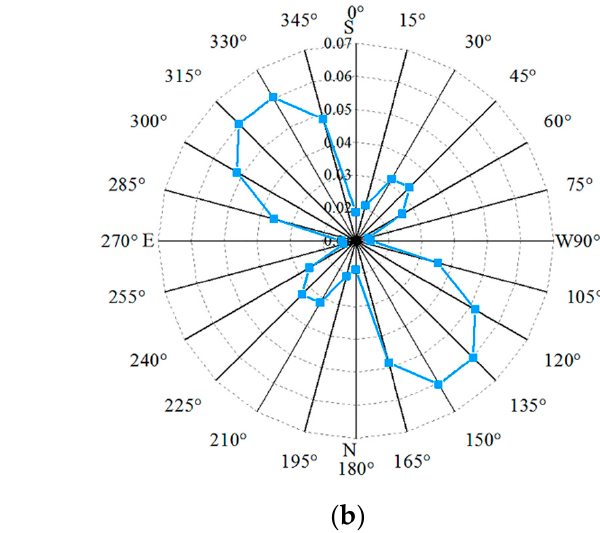
Figure 12. Variation of the monthly average effective tracking factor σ m of an SDC system under different azimuth axis tilt errors.